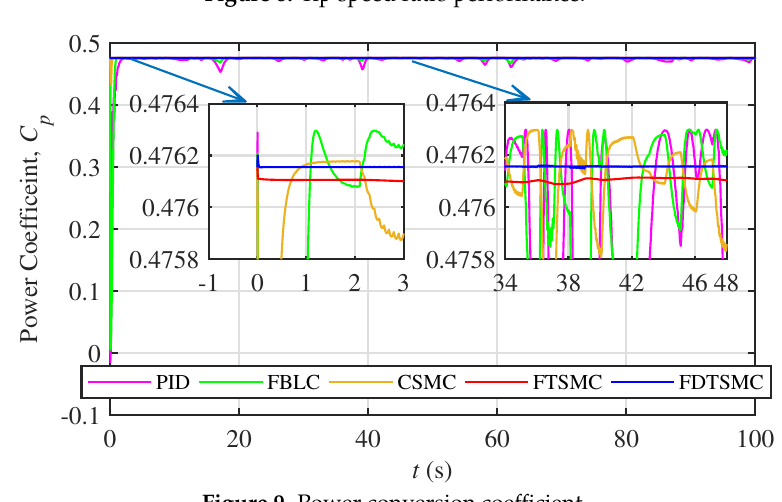
Figure 9. Power conversion coefficient.